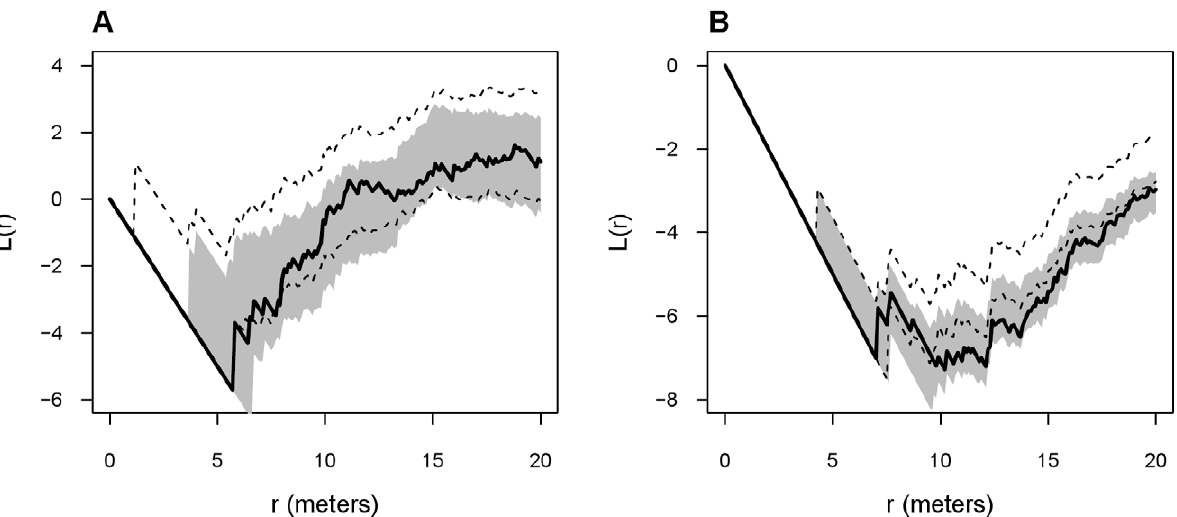
Figure 3. Goodness-of-fit for colony mortality risk spatial models. Comparison of the spatial statistic L(r) from observed spatial patterns and spatial patterns simulated from mortality risk models for surviving A) recently founded ant colonies and B) established ant colonies during 2009. Solid black lines represent the observed L(r) . Dashed lines and shaded areas are the 95% critical envelopes of L(r) generated from 999 Monte Carlo simulations of the random mortality model and logistic mortality model, respectively.